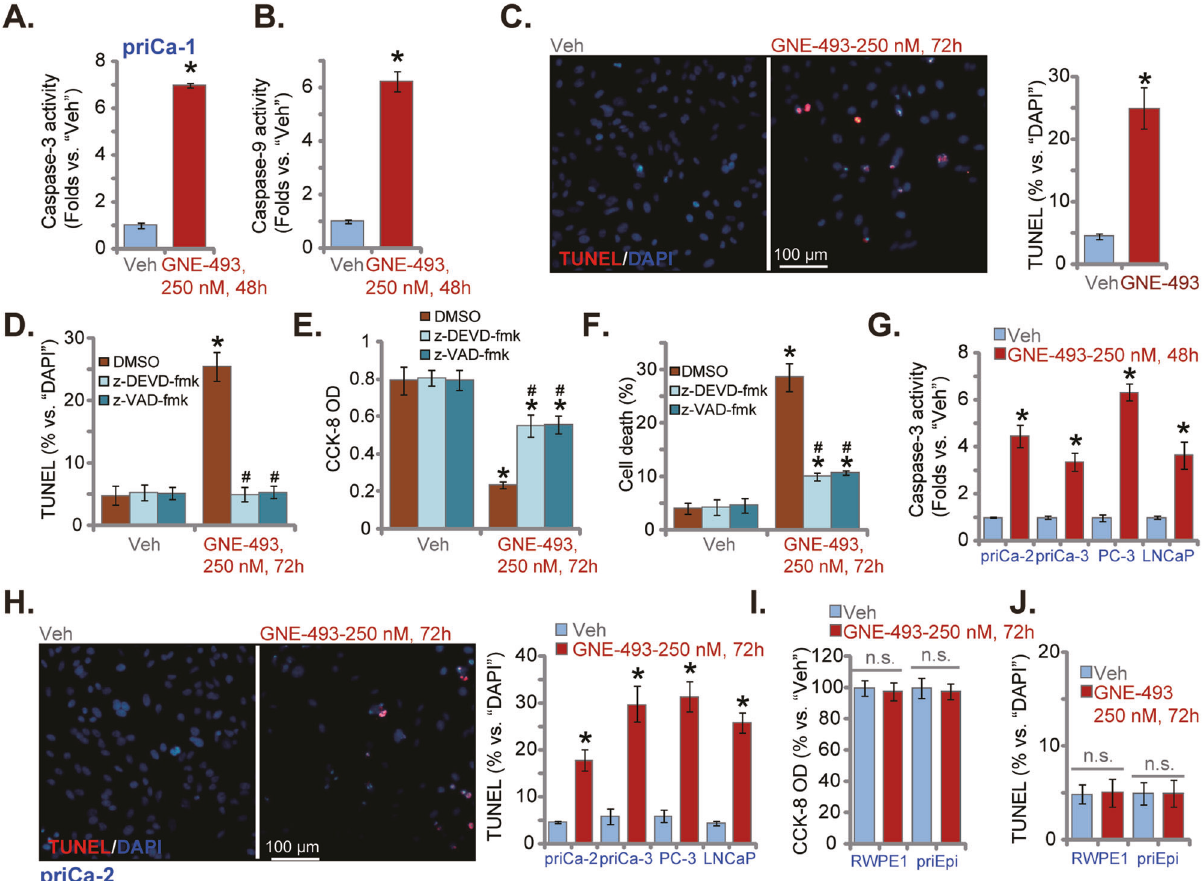
Fig. 2 GNE-493 provokes apoptosis in prostate cancer cells. The patient-derived primary prostate cancer cells (priCa-1/-2/-3) or the established cell lines (PC-3 cells or LNCaP) were cultivated in complete medium and stimulated with GNE-493 (250 nM) or the vehicle control (0.25% DMSO, “ Veh ” ); cells were further cultivated for designated time, the caspase-3/caspase-9 activities were tested ( A , B and G ). Cell apoptosis was examined by the nuclear TUNEL staining assay ( C and H ). The priCa-1 primary prostate cancer cells were pretreated with z- DEVD-fmk, z-VAD-fmk (for 30 min, each at 50 μ M) or the vehicle control (0.25% DMSO), cells were further treated with GNE-493 (250 nM) and cultivated for designated time, cell apoptosis, cell viability, and death were tested by TUNEL staining ( D ), CCK-8 ( E ) and Trypan blue staining ( F ) assays, respectively. The established Prostate epithelial RWPE1 cells or primary prostate epithelial cells ( “ priEpi ” ) were treated with GNE-493 (250 nM) or the vehicle control (0.25% DMSO, “ Veh ” ), and were cultivated for 72 h; testing cell viability and apoptosis were through CCK-8 ( I ) and nuclear TUNEL staining ( J ) assays, respectively. * P < 0.05 versus “ Veh ” group. # P < 0.05 versus GNE-493 treatment ( D – F ). “ n.s. ” stands for non-statistical difference ( I and J ). Scale bar = 100 μ m ( C and H